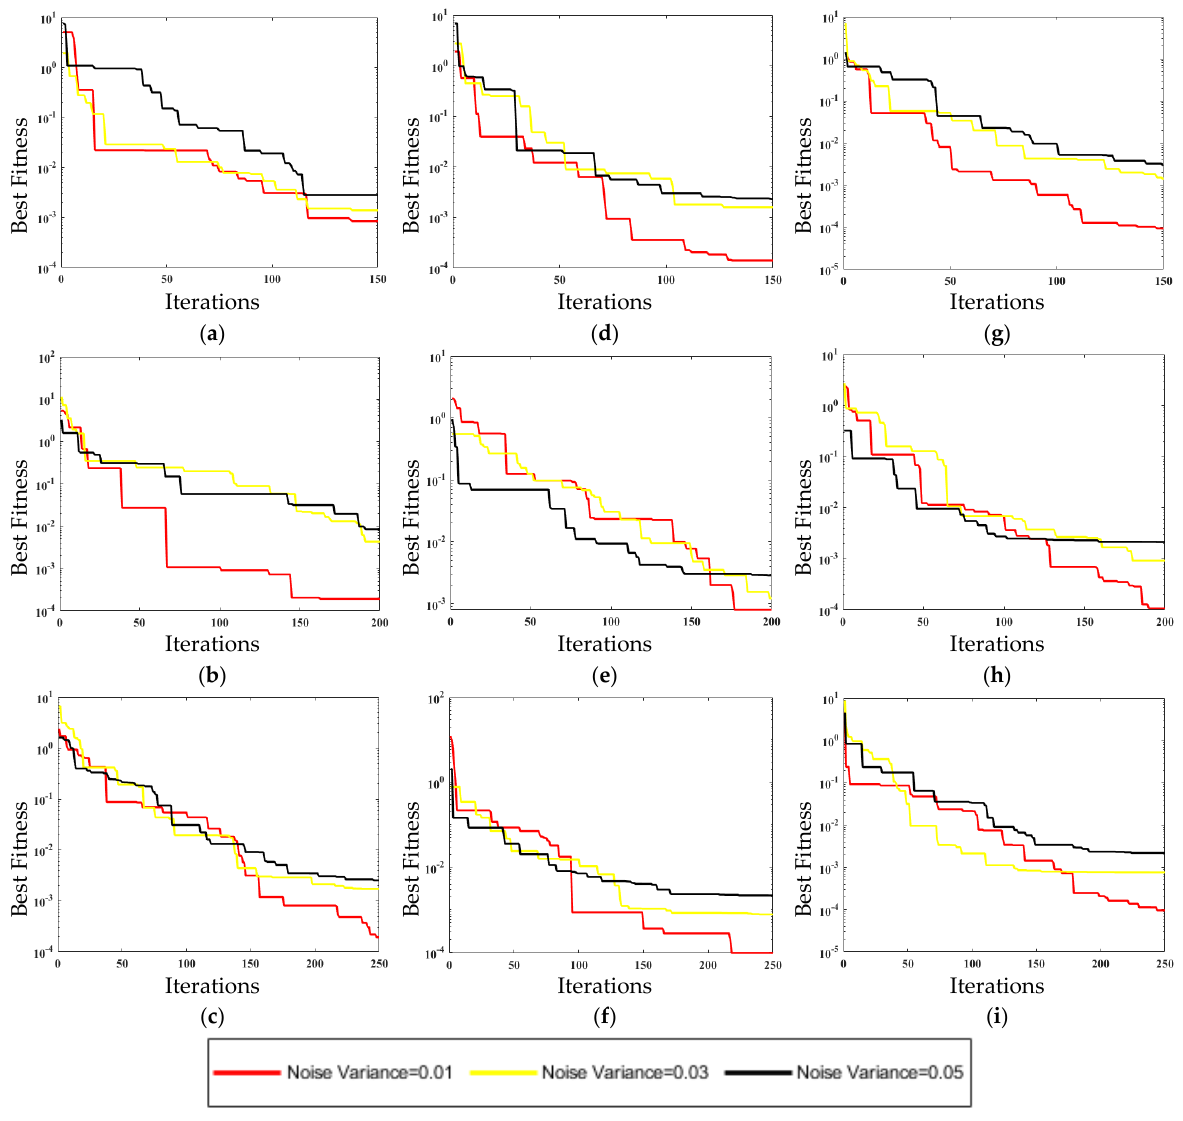
Figure 4. Fitness plots for the DMOA w.r.t noise variances. ( a – c ) Np = 15 ( d – f ) Np = 20 ( g – i ) Np = 25.